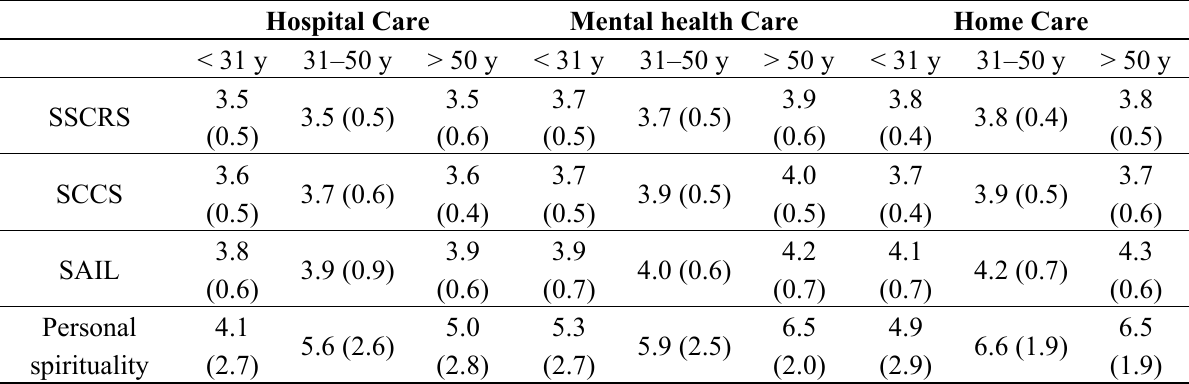
Table 2. Summary scores of standardized measures (with SD): SSCRS, SCCS and SAIL per age group and health care